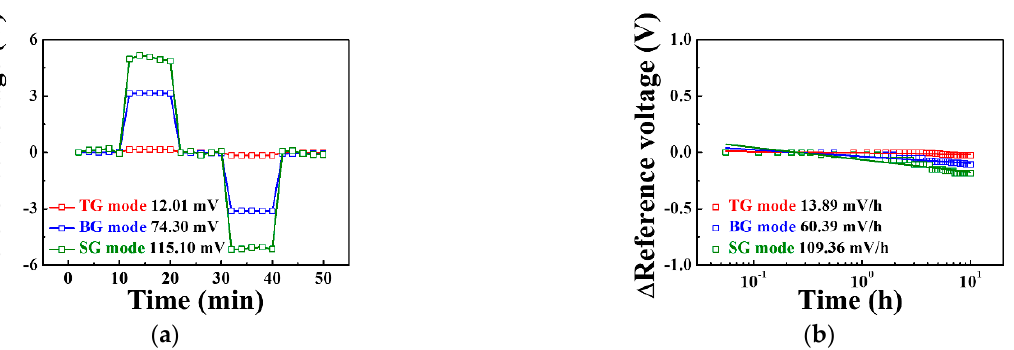
Figure 8. ( a ) Hysteresis voltage and ( b ) drift rate of the triple-gate a-IGZO TFT-based pH-ISFET sensor platform in the TG, BG, and SG modes. Table 3. pH sensing parameters of the triple-gate a-IGZO TFT-based pH-ISFET sensor platform in the TG, BG, and SG modes. Amplification refers to the amplified ratio of each mode relative to the TG mode.